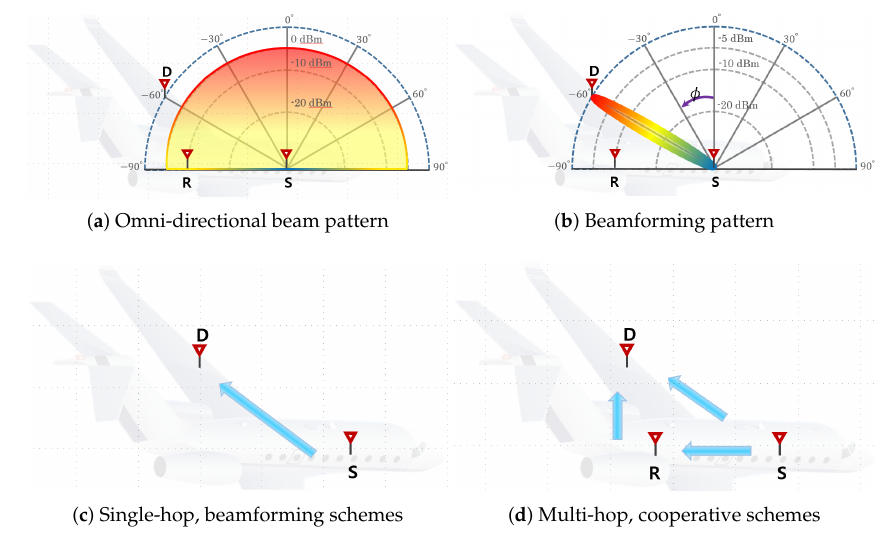
Figure 1. Examples of the system